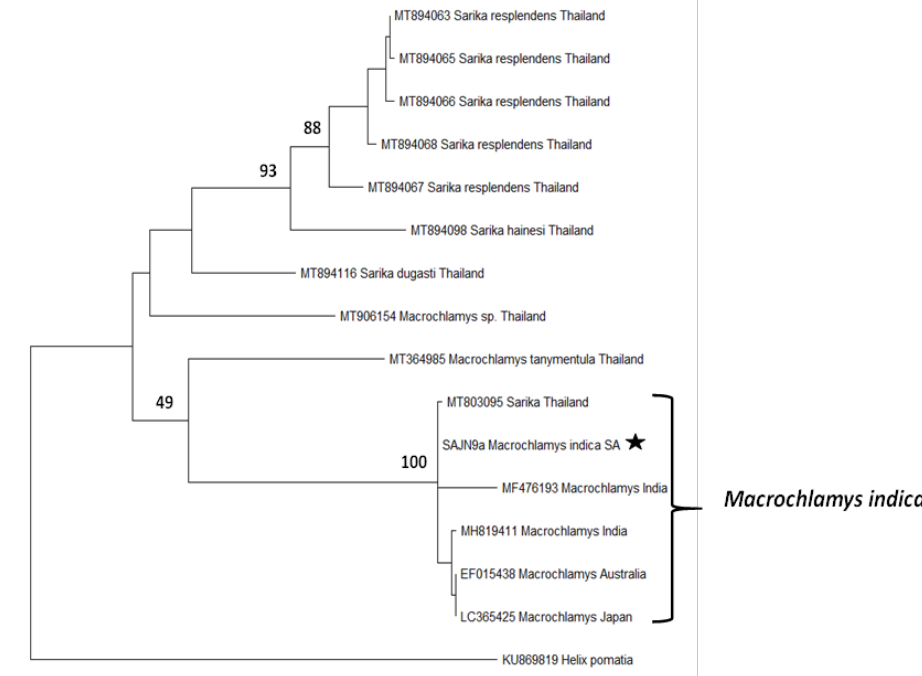
Figure 7. Maximum Likelihood tree obtained from aligned COI sequences from Macrochlamys and Sarika snails. The star-labeled SAJN9a COI Saudi haplotype represents 24 sequences obtained from 10 snail populations collected from different locations in Saudi Arabia (SA). The other homologous COI sequences were retrieved from the NCBI-GenBank database. Helix pomatia (accession number KU869819) was used as an outgroup taxon. Bootstrap values (1000 replicates) are given on the tree branches. Table 4. Pairwise p-distances calculated from COI sequences from Macrochlamys and their closely relative snails.